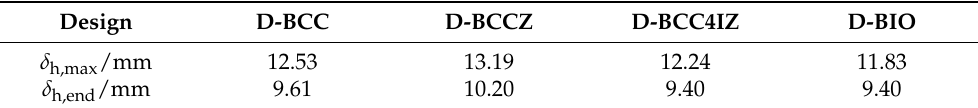
Table 7. The δ h value of four